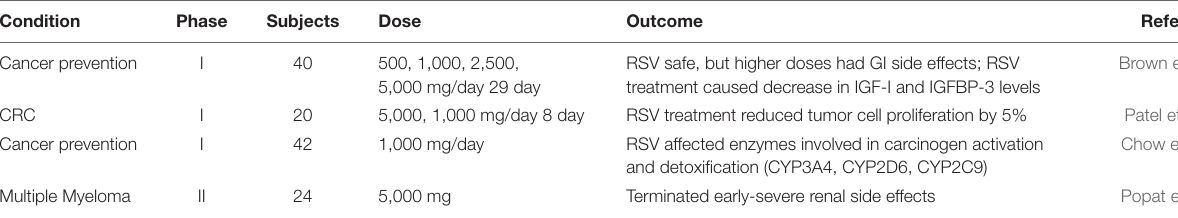
TABLE 2 | Resveratrol clinical trials for cancer.